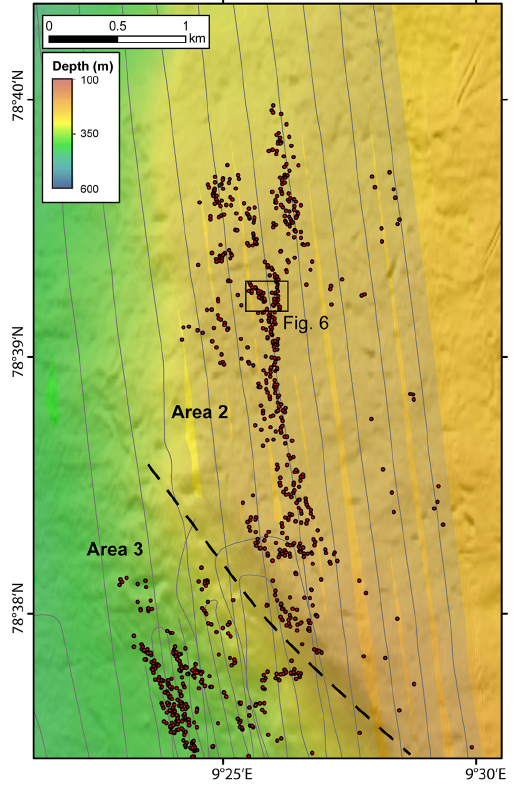
Figure 5. Flares (circles) in Area 2 (240 to 245m water depth) plot- ted on shaded bathymetry. Flares were picked in multibeam water column data; the coverage is shown as gray shading around the ship track (lines). ROV dives were performed in an area highlighted by the rectangular box (Fig. 6).